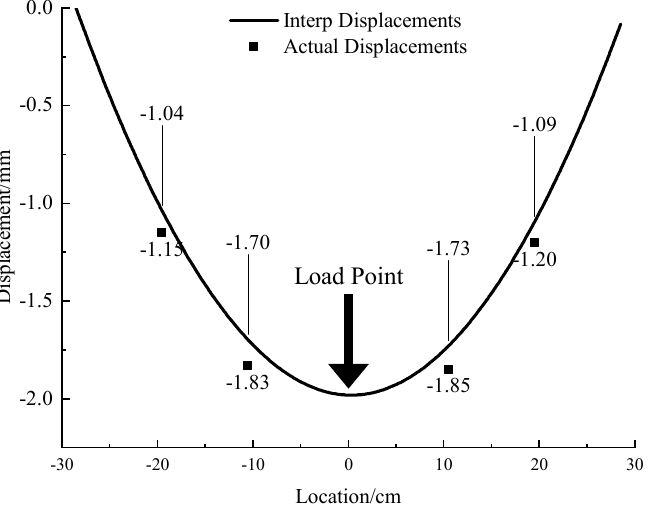
Figure 5. Deformation curve and measured displacement of single acrylic tunnel with 1 mm thickness under concentrated load.